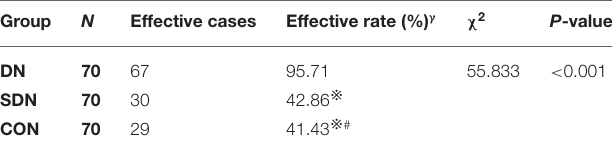
TABLE 2 | Effective rate of thumb spasticity relief from baseline to after each